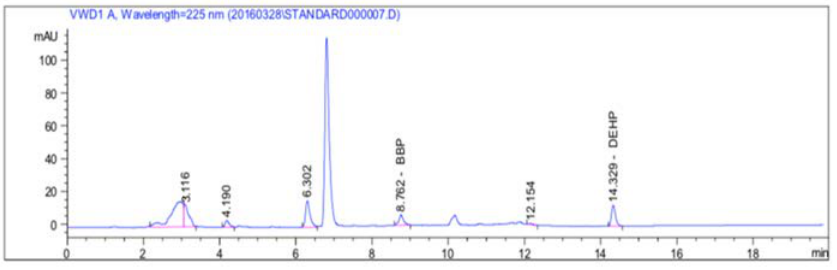
Figure 1. Chromatogram, HPLC, of a DEHP standard solution of concentration 0.7 mg/L, to check the specificity of the method.